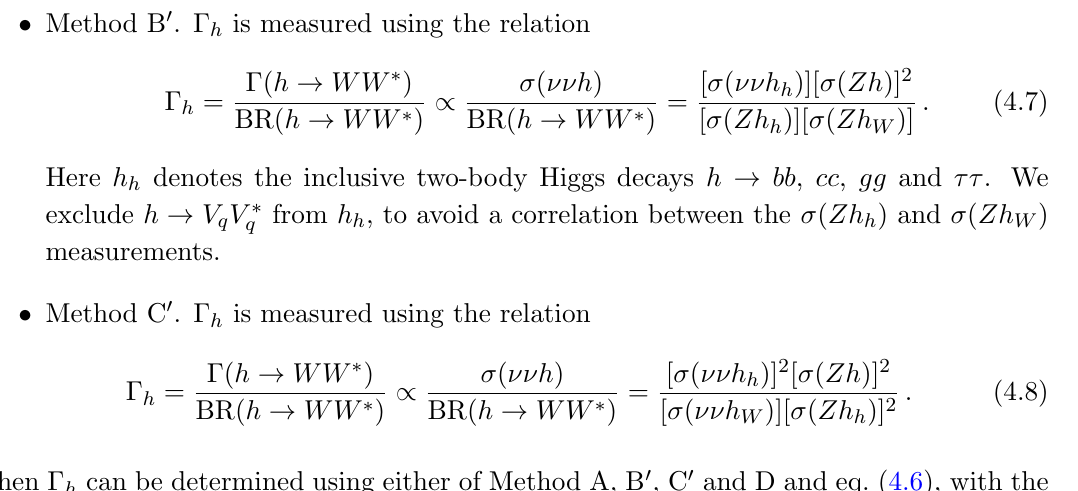
Table 4 . Expected precisions of measuring the SM (cid:0) h at e (cid:0) e + colliders. The CEPC 240 precisions are extrapolated from the CEPC 250 ones (inside the parentheses) [17, 19]. The numbers marked with \ (cid:3) " are derived from table 3, using eq. (4.6). relatively inclusive way. This idea can be also applied to Method C. We term these inclusive methods